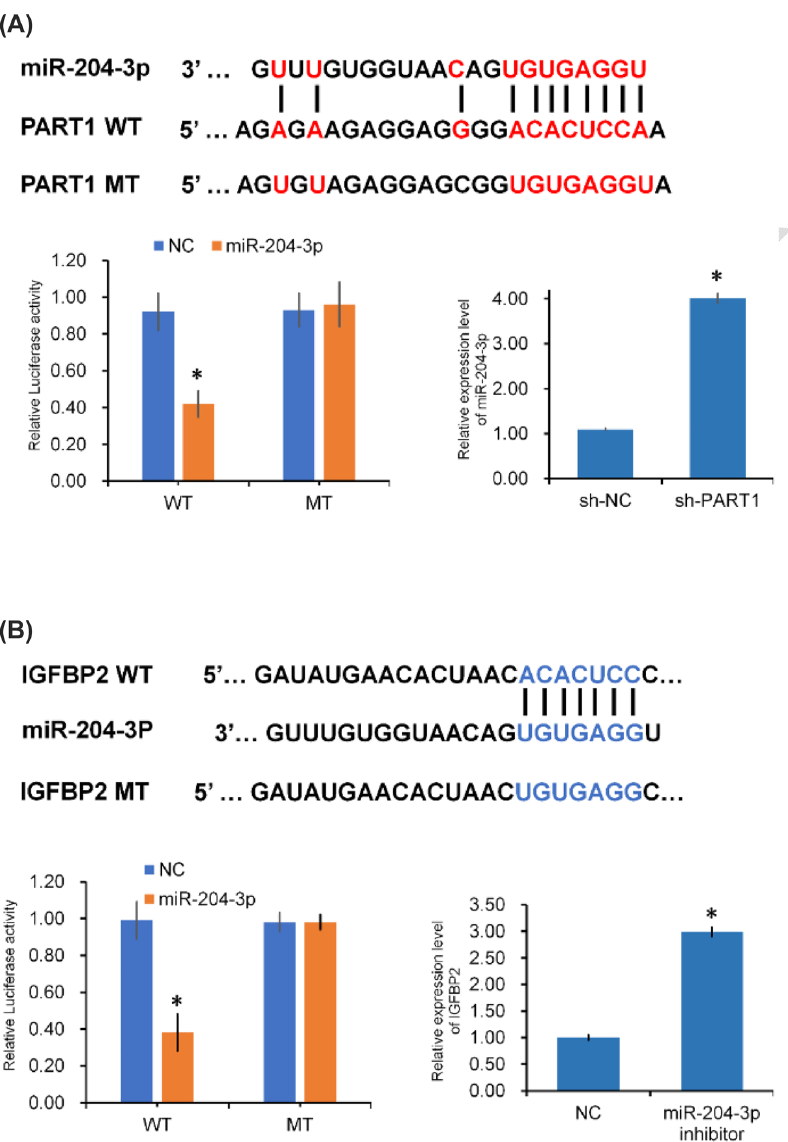
Figure 4: PART-1 targeted miR-204-3p and miR-204-3p targeted IGFBP-2. (A) The potential binding site betweenPART-1 and miR-204-3p; dual-luciferase reporter assays con fi rmed the interaction between PART-1 and miR-204-3p. The relative expression level of miR-204-3p in sh-PART1 cells compared with that in sh-NC cells. (B) The potential binding site betweenmiR-204-3p andIGFBP-2 and dual-luciferase reporterassays indicated the interaction between miR-204-3p and IGFBP-2. The relative expression level of IGFBP-2 in miR-204-3p-inhibited cells compared with that in negative control cells. *Indicates